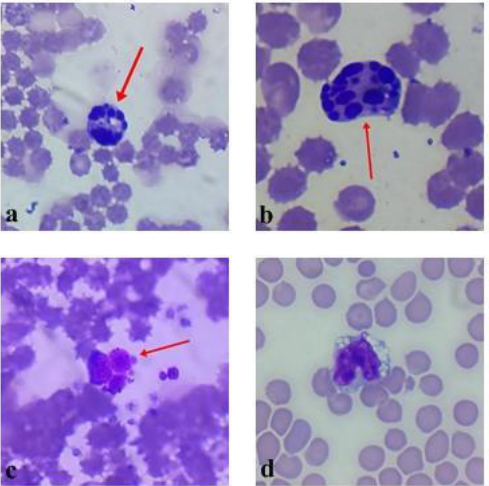
Figure 3. ( a – d ) Represent abnormalities of cell that were detected in peripheral blood of mice after treatment with EP hemagglutinin LysM. ( a – c ) Represent leucocyte cells with defragmented (apoptotic) nucleus. ( d ) Vacuolated band neutrophil. No cell abnormalities were detected in groups of negative control and EP tincture.